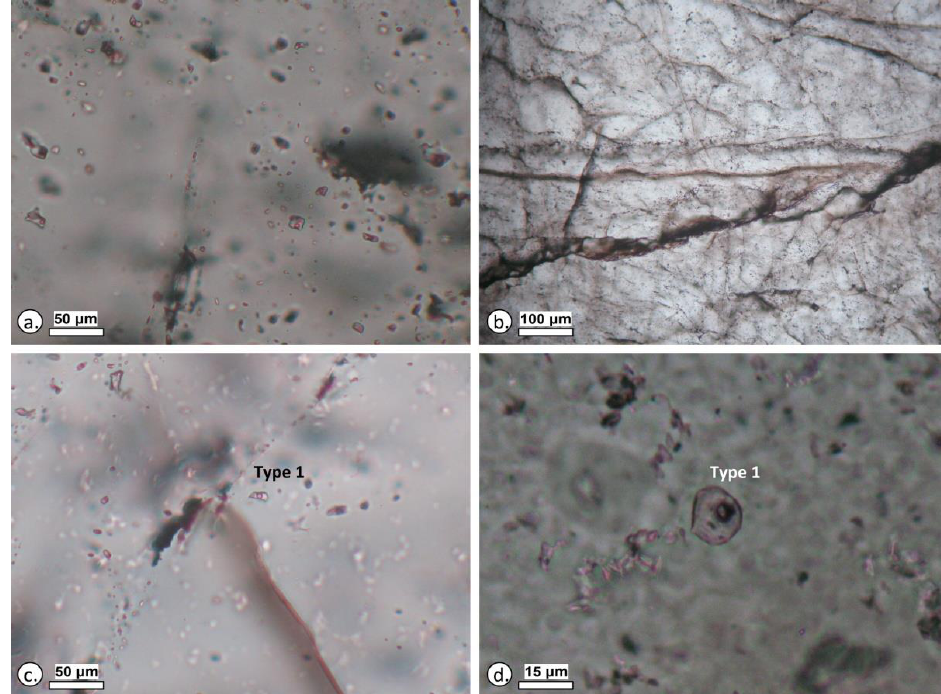
Figure 13. Fluid inclusions in quartz from the stibnite mineralization at Rizana: ( a ) Clusters of fluid inclusions where recrystallization did not significantly affect the quartz; ( b ) Secondary inclusions of very small size (<1 μm) along healed fractures in the quartz; ( c , d ) Two-phase fluid inclusions of type 1.